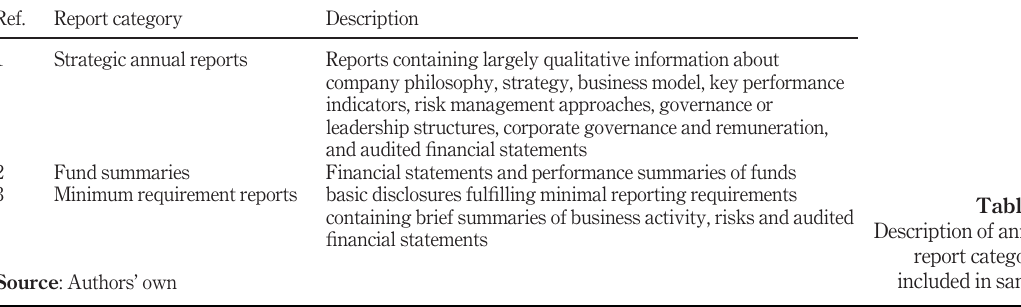
Table 1. Description of